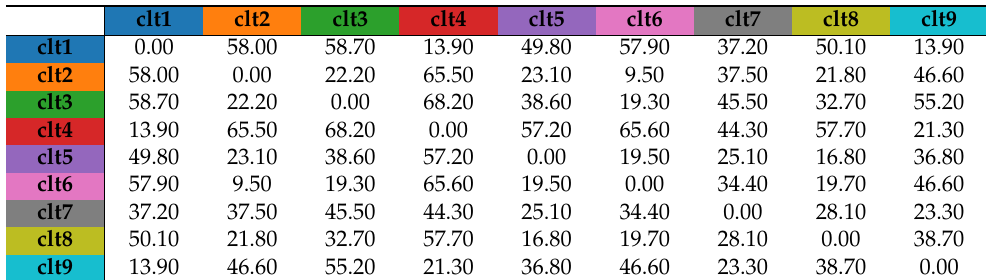
Figure 9. Battery 2 mean probability distributions computed along each dimension (sensor). The solid color lines are those of the clusters, and the dashed black line is that of the database. Normalized sensor values in abscissa and empirical probability of appearance in ordinate. Table 8. Battery 2 pairwise KS test of the clusters. All probabilities expressed in percentages ( × 100). See Table 3 for the details about the color